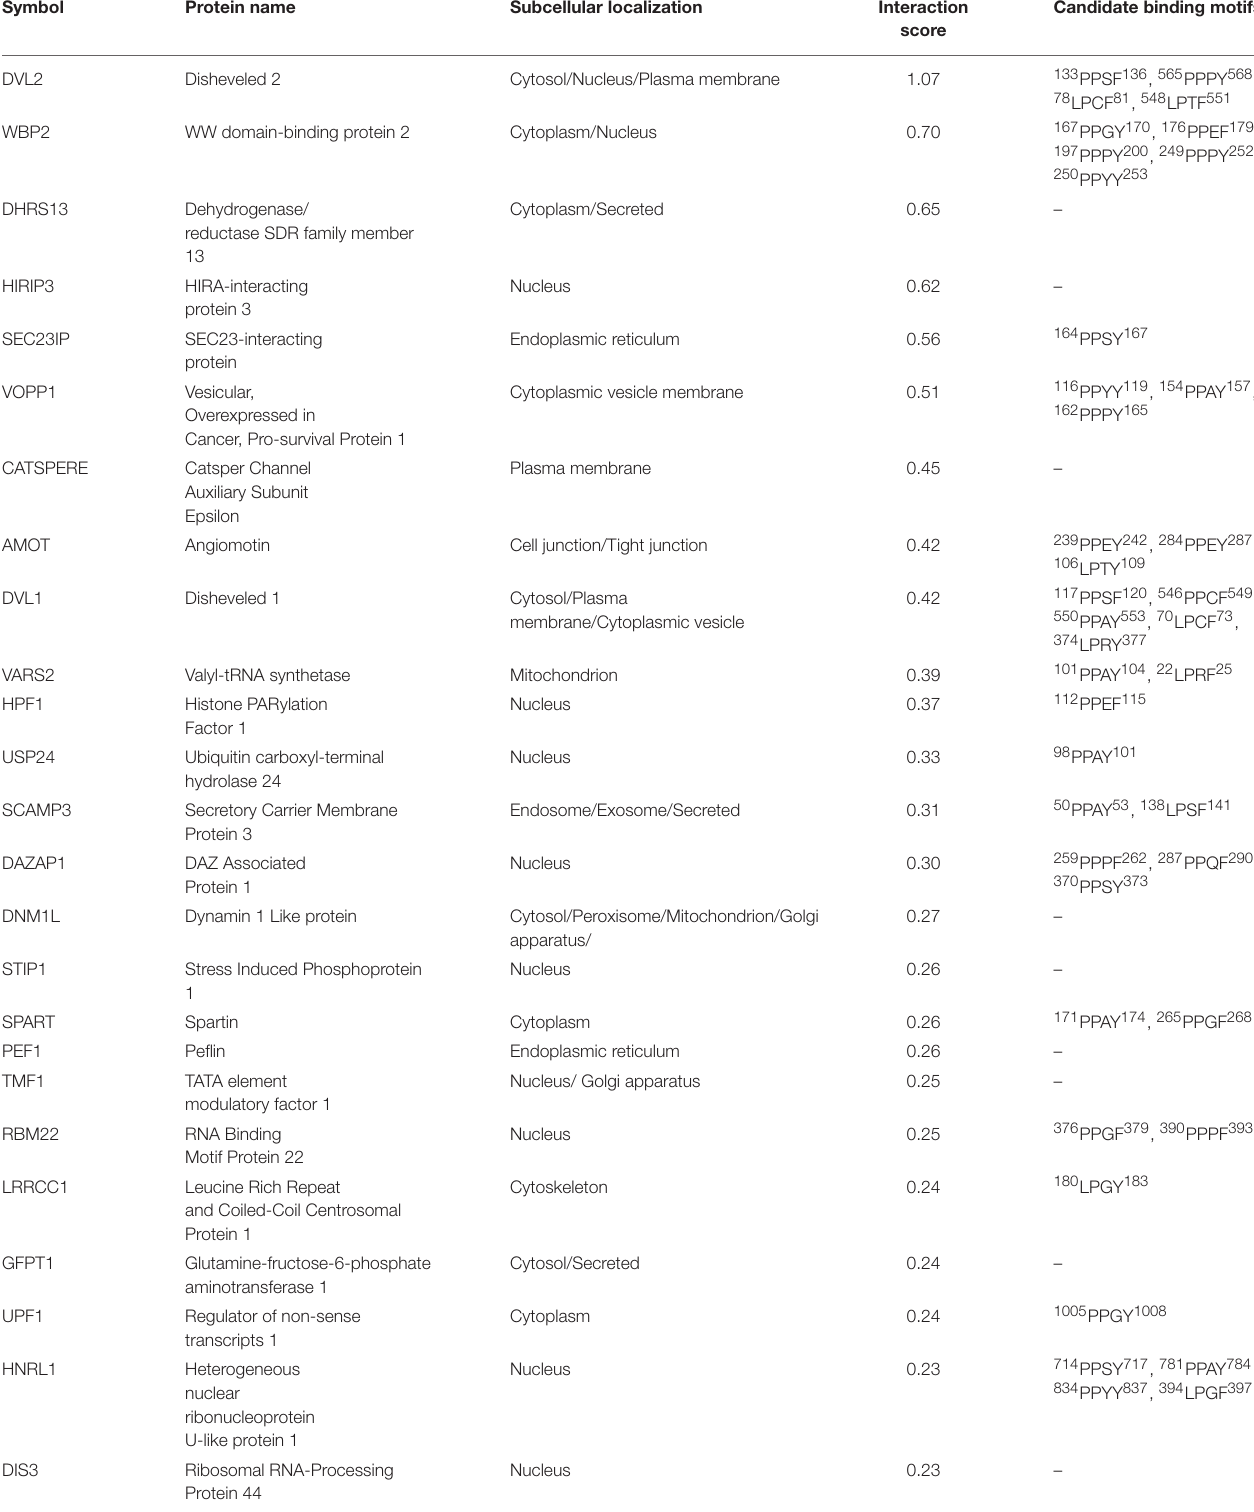
TABLE 1 | Candidate WWOX interacting proteins with highest confidence interaction scores.